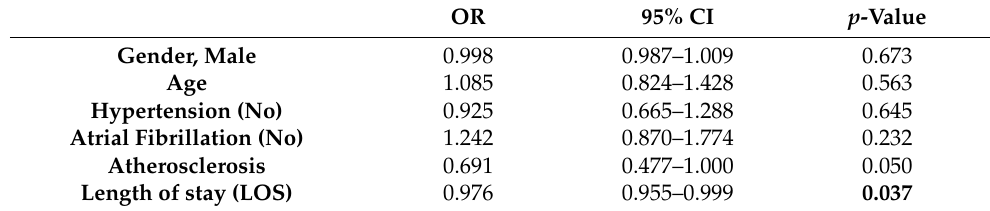
Table 9. Logistic regression — Stroke patients.